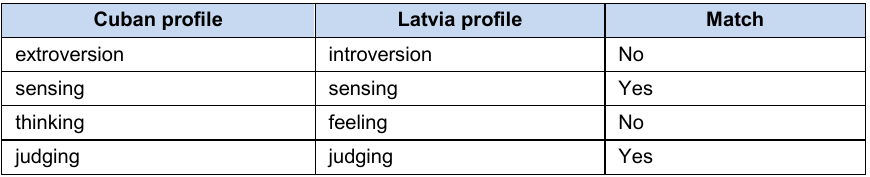
Table 5. Dimension